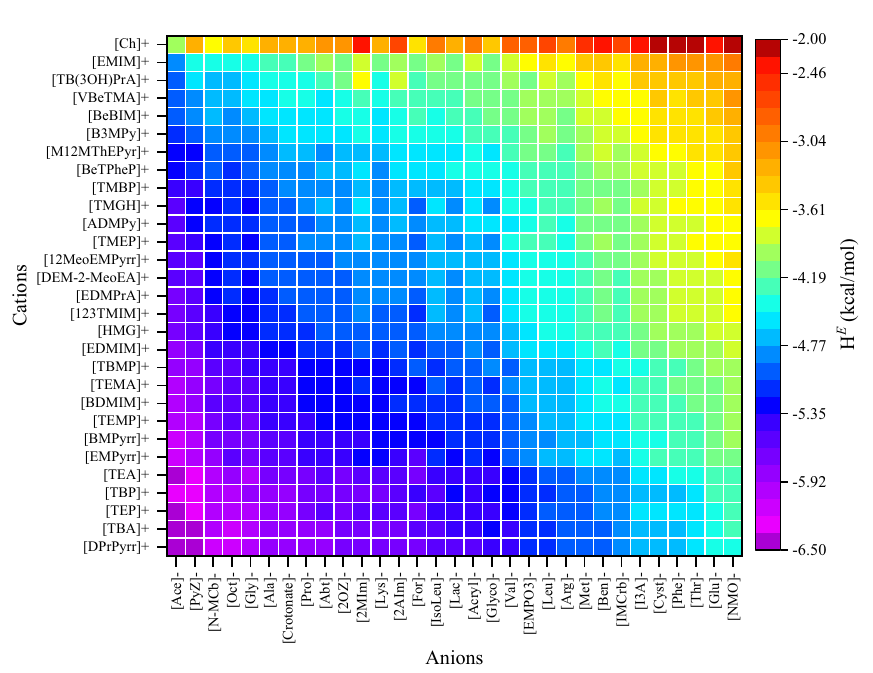
Figure 3. Graphical representation of the excess enthalpy, H E (kcal/mol) of lignin in different ILs at 363.15 K by COSMO-RS model. Origin2020 SR1 used to draw the heatmaps (https:// www. origi nlab. com/